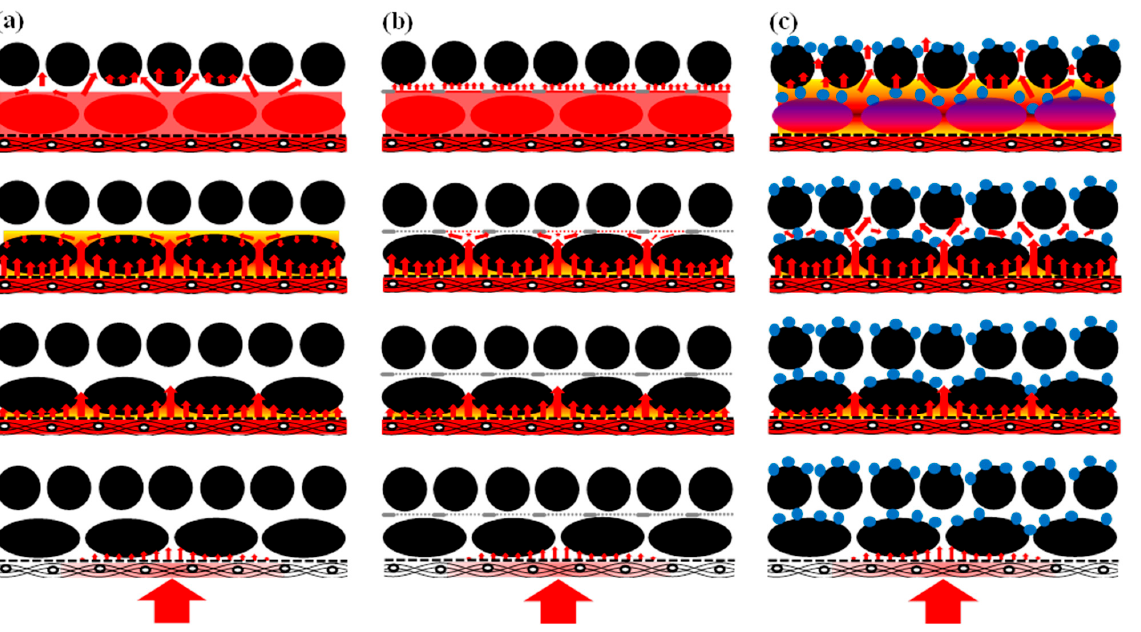
Figure 7. Deduction of z-directional flow and infiltration model. ( a ) NT-Preform; ( b ) NWT-Preform; ( c ) DMT-Preform.